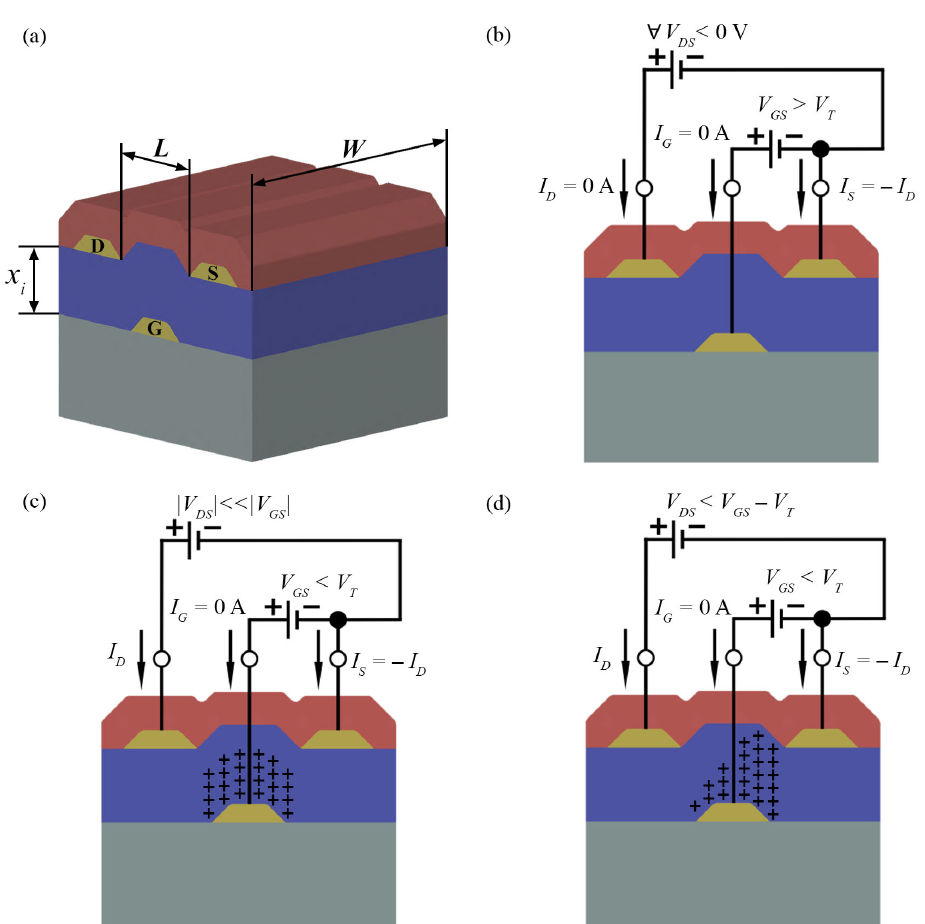
Figure 3. P-type field-effect-transistor (FET): ( a ) structural parameters and device electrodes; ( b ) cut-off ( c ) triode and ( d ) saturation operating